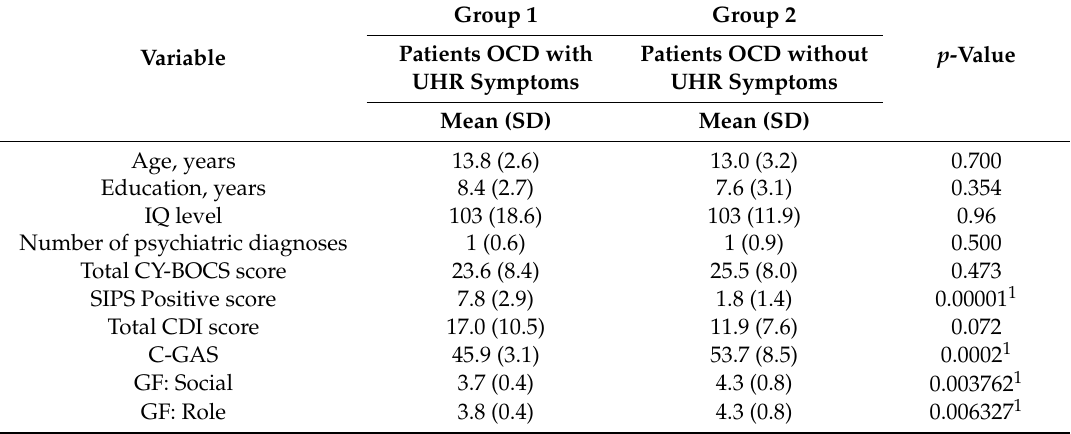
Table 1. Socio-demographic data and psychiatric assessment scores separately for two